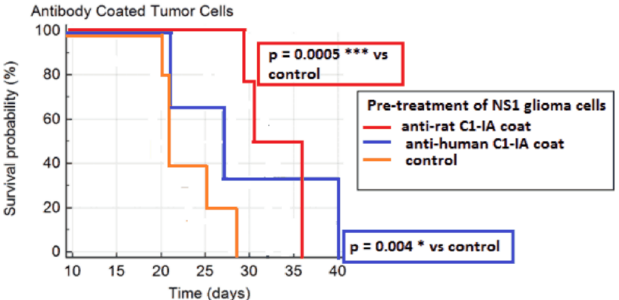
Fig 5. Animals inoculated with glioblastoma cells coated with anti-C1-IA antibodies had a significantly longer mean survival as compared to the control animals. No side effects of antibody coatingwas